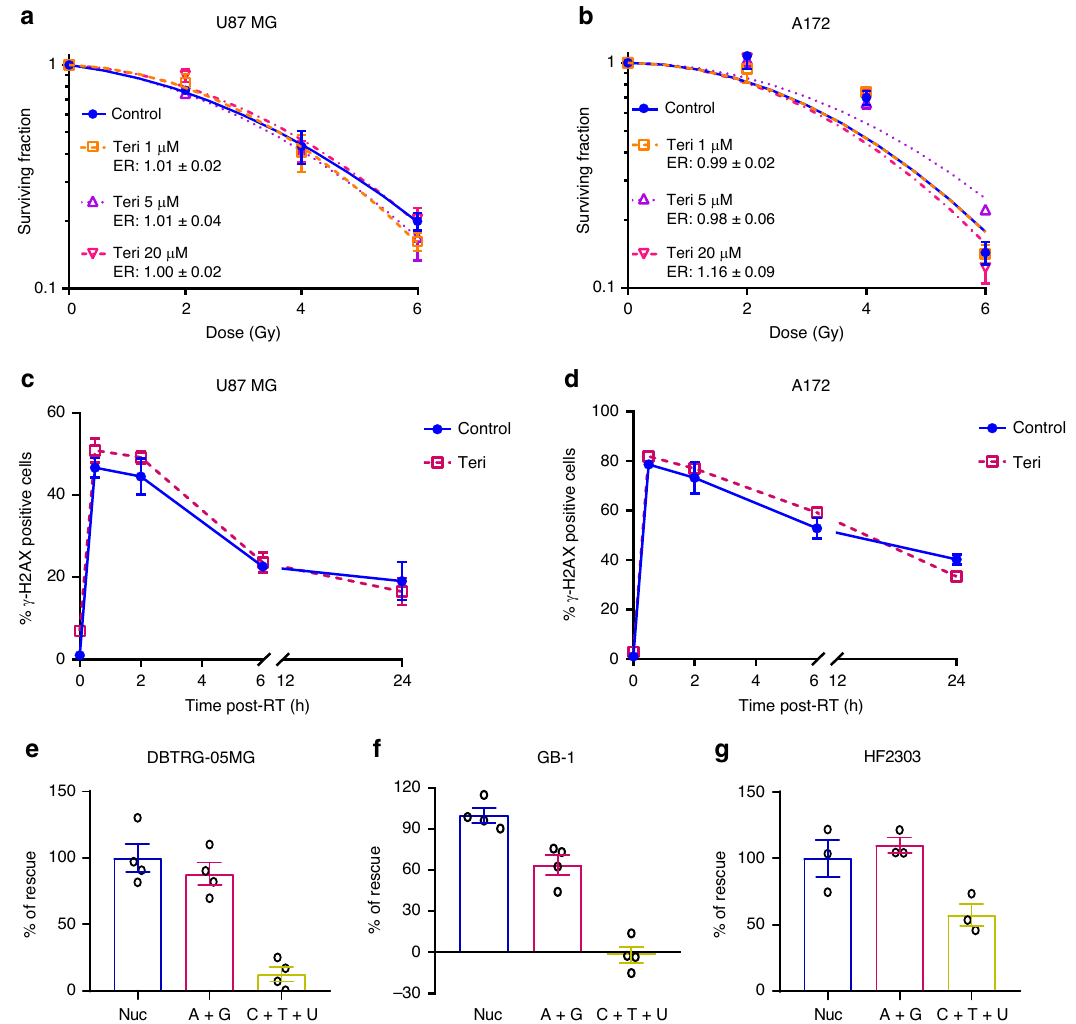
Fig. 5 Modulating pyrimidine pools has minimal effects on GBM DNA repair and RT-resistance. a, b U87 MG and A172 cells were treated with varying doses of teri fl unomide (Teri) for 24 h, and then irradiated. Cells were replated for colonogenic assay 24 h post-RT. Individual plots show data from one of three biologic replicates and error bars indicate mean ± SEM of technical replicates from that experiment. ER show the mean ± SEM from all three biologic replicates. c , d Cells were treated with 20 µ M teri fl unomide for 24 h and then irradiated with 4 Gy, and cells were harvested at indicated time point post-RT for γ -H2AX foci staining. Data points are averages (mean ± SEM) from three biologic replicates. Cells were treated with pooled nucleosides (Nuc; 8×), or a combination of Adenosine + Guanosine (A + G), or Cytidine + Thymidine + Uridine (C + T + U) for 24 h, and retreated with indicated nucleosides 2 h before RT (4 Gy), followed by IF γ -H2AX foci staining 6 h post-RT. For Fig. e – g , data are presented as mean ± SEM from four ( e , f ) or three ( g ) biologically independent experiments. Source data are provided as a Source Data fi